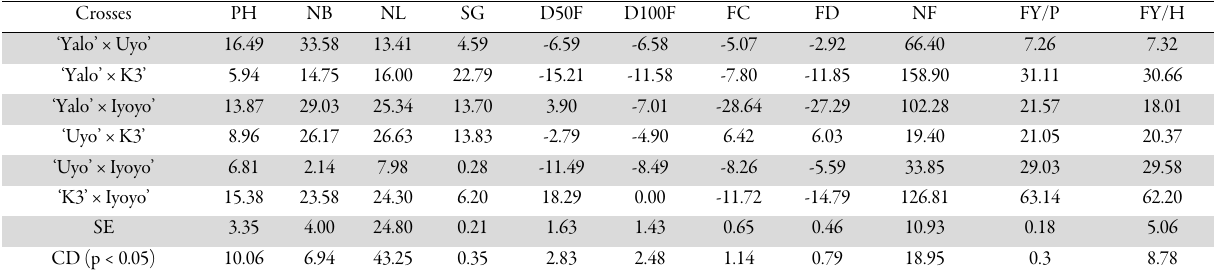
Table 1. Estimates of heterosis (%) in F 1 over the mid parents (MP) for 11 agronomic traits of eggplant genotypes Crosses PH NB NL SG D50F D100F FC FD NF FY/P FY/H ‘Yalo’ × Uyo’ ‘Yalo’ × Iyoyo’